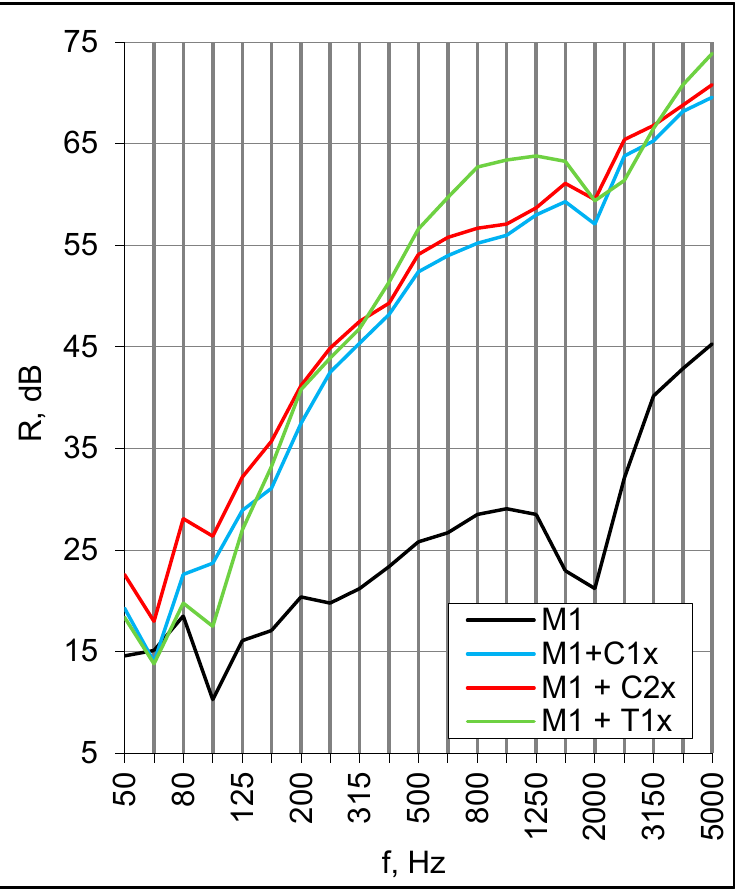
Figure 11. Sound reduction index of M1 panel with a suspended ceiling and top insulation. Table 4. Single number values of M1 panel with additional insulating layers.